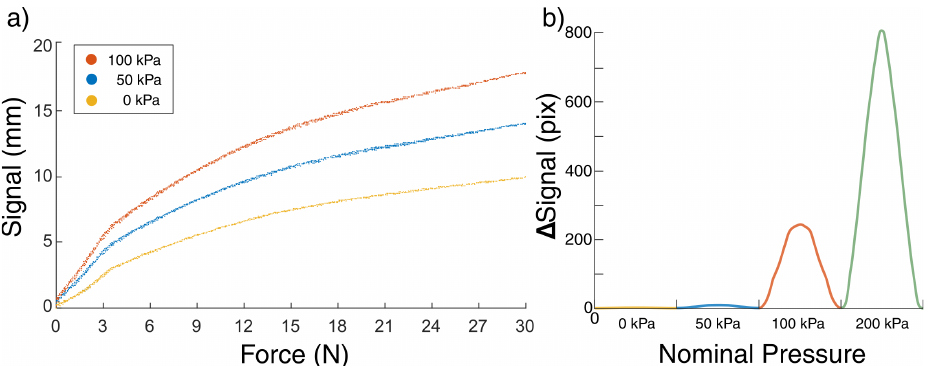
Figure 5. Changing behaviour when applying an internal pressure to a 2.5 mm sensitive membrane. ( a ) The signal (observable movement of the meniscus) is significantly increased when the back- pressure is doubled. The graph shows all data collected over 10 palpations of the F/T sensor at 3 nominal pressures. A function was fitted to each of these curves so that the force could be calculated from the P 0 and signal. Under 3 N, the three states of nominal pressures 0, 50, and 100 kPa have approximately constant stiffnesses of 2.02, 1.18, and 0.56 N/mm, respectively. ( b ) 1 s oscillations between 35 and 40 N. At high forces, a back pressure can be applied ad hoc to recover sensitivity. With no stimulus present, a 200 kPa internal nominal pressure is likely to break the silicone